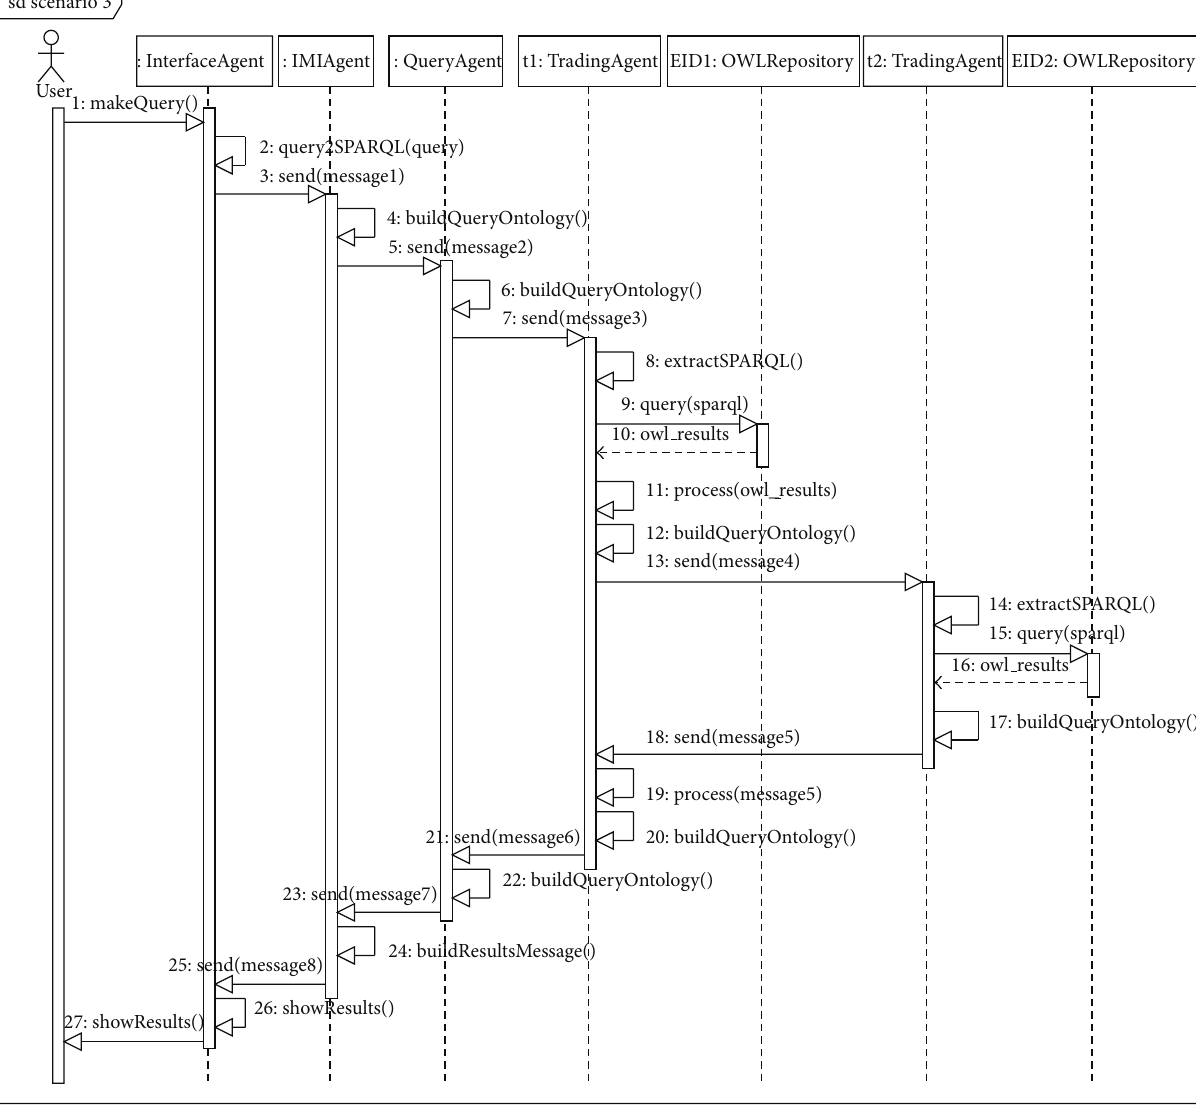
Figure 13: Sequence diagram for Scenario number 3